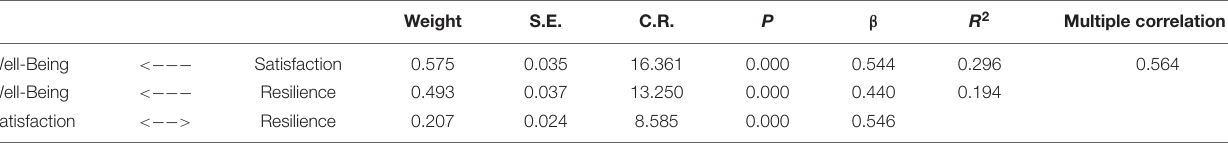
TABLE 5 | Results of multiple linear regression analysis with SEM.